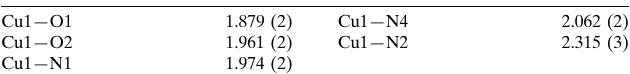
Selected bond lengths (A˚